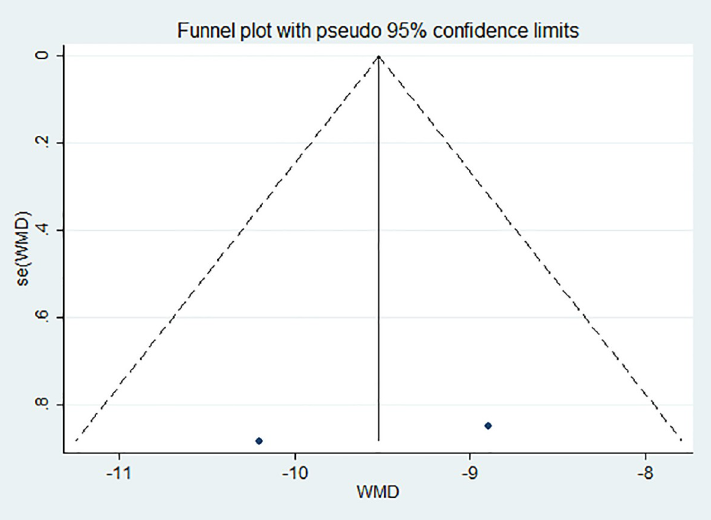
Fig 5. Publication bias among the papers. The bilirubin level of the case group was concentrated in the 15–20 mg/dl range is Fig 5.